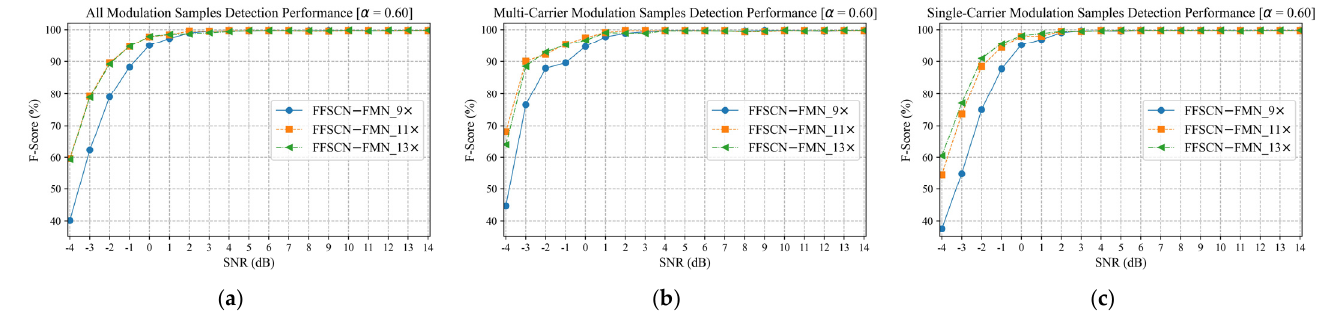
Figure 10. The multi-carrier and single-carrier modulation signal detection performances of different downsample times used in the FFSCN-FMN model: ( a ) all modulation samples’ detection performance; ( b ) multi-carrier modulation samples’ detection performance; ( c ) single-carrier modulation samples’ detection performance. Here, α denotes the IoU threshold, and we fixed it to 0.6. We compared the performance of the FFSCN-FMN model using 9, 11, and 13 downsample times.